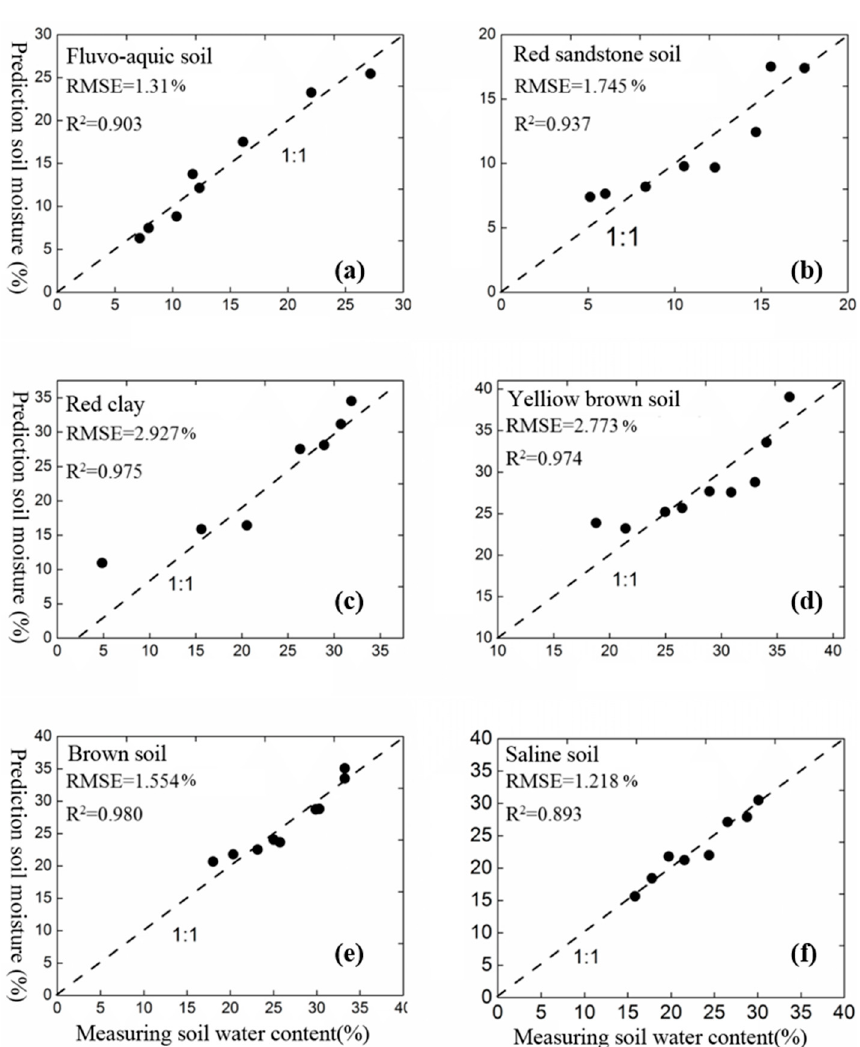
Figure 7. Regression analysis of the measured SWC and the θ ~ ε model-retrieved SWC. ( a ) fluvo-aquic soil; ( b ) red sandstone soil; ( c ) red clay; ( d ) yellow brown soil; ( e ) brown soil; ( f ) saline soil.